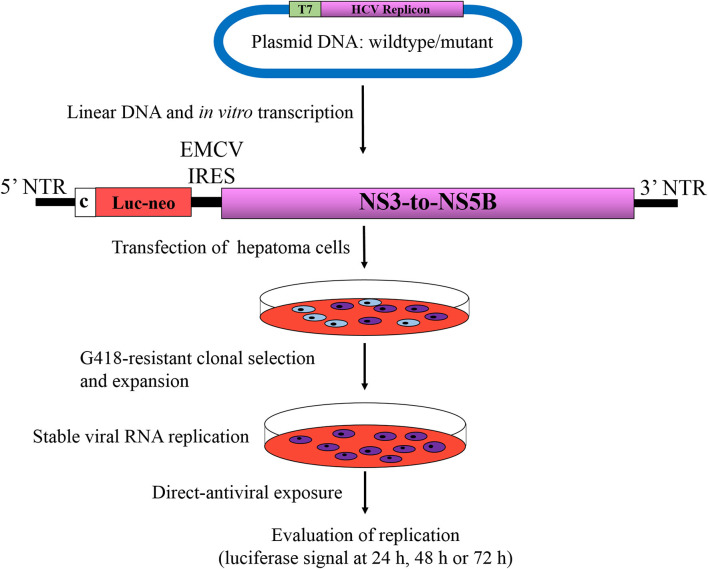
Phenotypic assay of HCV resistance to antivirals. Bicistronic replicons described in Figure 2D are the most widely used systems for determination of phenotypic direct-acting antiviral resistance. Replicon RNAs from wild type or mutant are synthesized by in vitro transcription of linearized plasmids harboring HCV replicon, which are then transfected into hepatoma cells, subsequently subjected to G418 selection pressure for 3–4 weeks. Cells harboring active replicon RNAs become resistance to G418 due to expression of neo gene, whereas untransfected cells or cells that do not support RNA replication will be eliminated during the process. After the establishment of stable cell line supporting HCV autonomous replication, cells are subjected to increasing antiviral concentrations based on of EC50 or EC90 values. The level of susceptibility is evaluated by measuring the luciferase activity at 24, 48, and 72 h after treatment, in comparison to its wild type counterpart, which is commonly expressed as fold resistance. Luc-Neo, fused luciferase and neo gene encoding neomycin phosphotransferase; c, core; EMCV IRES, internal ribosomal entry site from encephalomyocarditis virus. Viral and non-viral coding sequences are marked by rectangles; non-coding regions are indicated by horizontal lines.